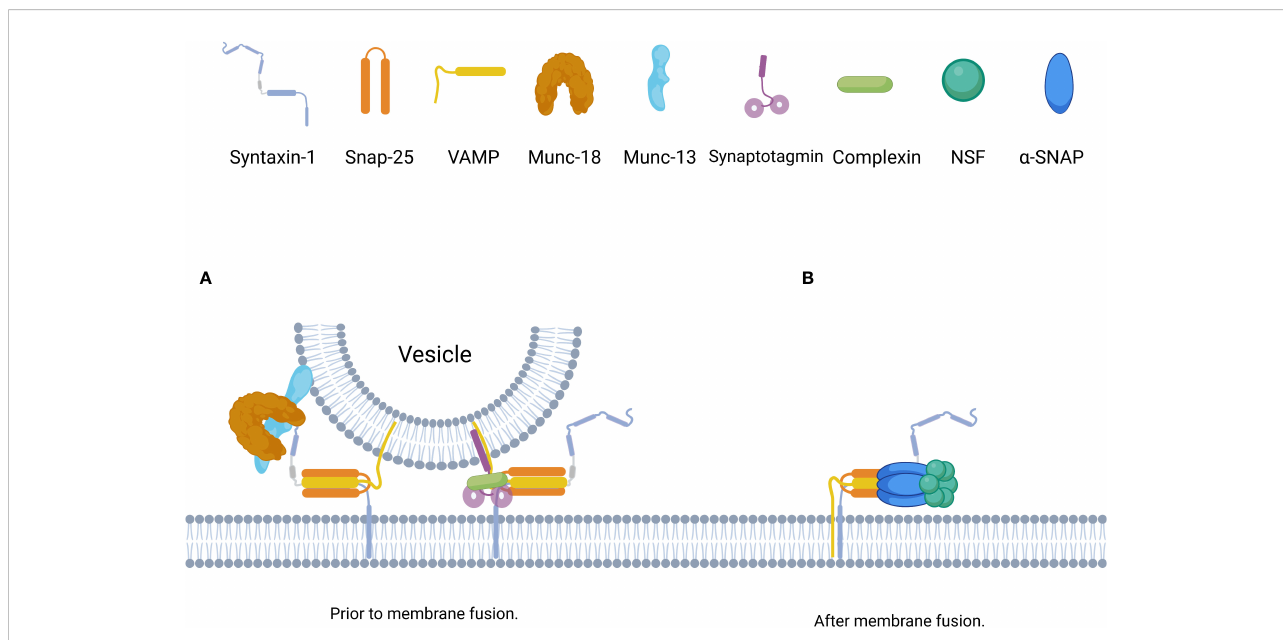
FIGURE 3 Schematic of the assembly and disassembly of the SNARE complex governed by distinct SNARE accessorys. (A) Prior to membrane fusion, the accessory proteins, including complexin, synaptotagmin, Munc18, and Munc13, form a basic interaction module with individual SNARE complexes. Munc18-1 and Munc13-1 bind to Syntaxin-1 to initiate and template the assembly of SNARE complexe, synaptotagmins and complexin bind to SNARE complexe to stabilize and lock SNARE complexe in intermediate states until Ca 2+ binding to synaptotagmins. (B) After membrane fusion, trans-SNAREs are converted to cis-SNAREs which with both the Syntaxin-1 and VAMP residing in the same membrane,and can be disassembled by the joint action of a -SNAP and NSF with